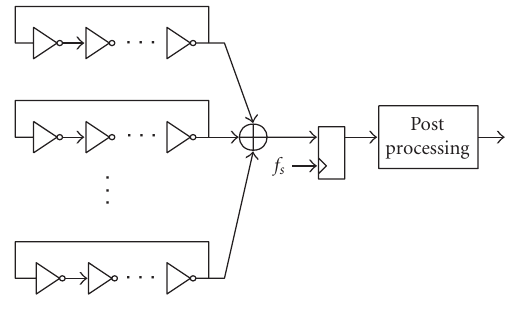
Figure 1: TRNG based on oscillator rings